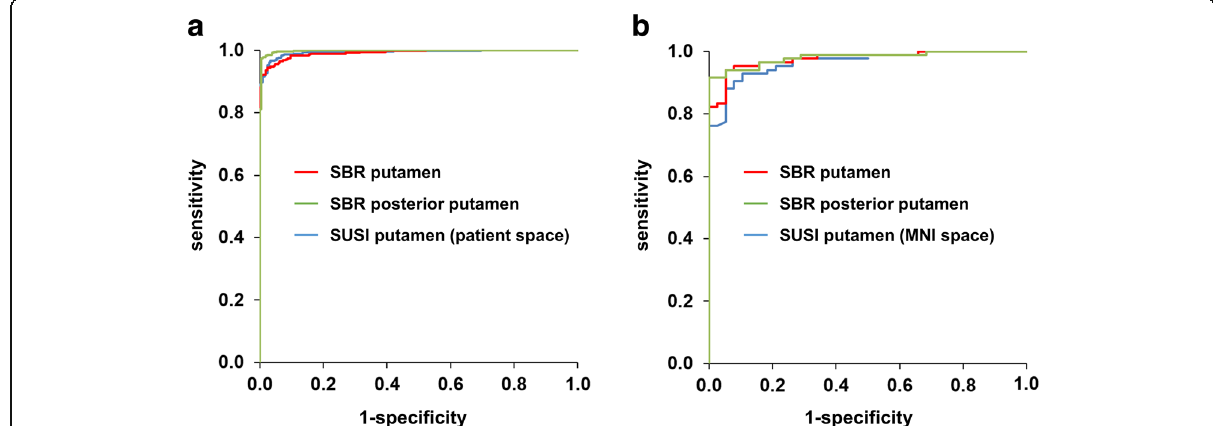
Fig. 2 ROC curves for identification of neurodegenerative etiology of parkinsonism (mono-site/mono-camera setting, a ) or PD (multi-site/multi- camera setting, b )